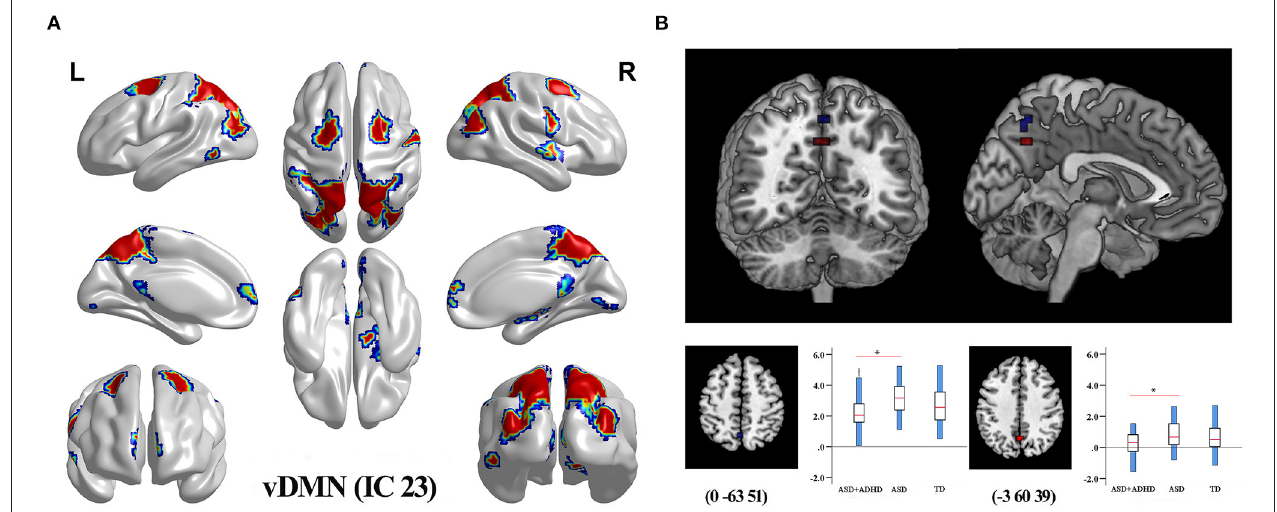
FIGURE 2 | Differences in within-network connectivity in the triple-network model (A) The mask of IC 23 belonging to vDMN generated by composing the results of one-sample t -test of each group ( q < 0.01, FDR correction). (B) ASD + ADHD group had lower FC in the left and inter-hemispheric precuneus of the vDMN compared with the ASD group.